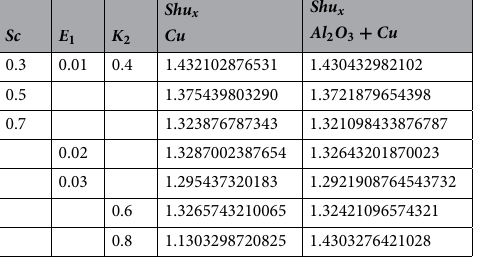
0.5 Table 3. Shu x Re − x numerical values versus various parameters.